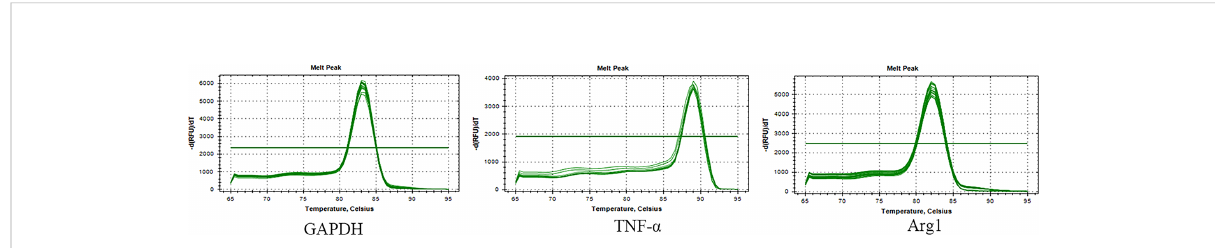
FIGURE 4 Melting curves of macrophage genes and GAPDH genes. Single peak of the curve indicates the speci fi city of the designed primer.